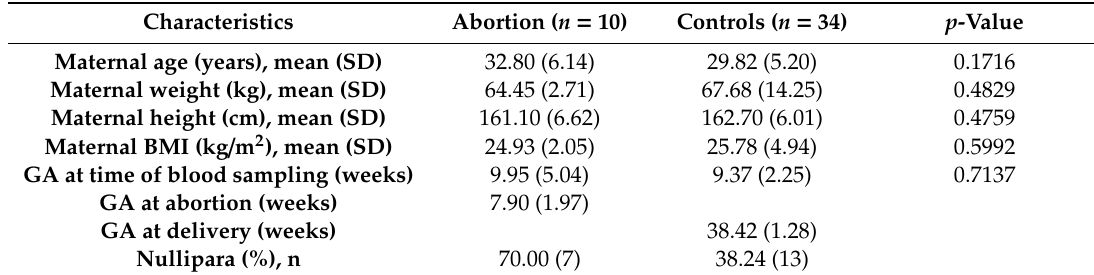
Table 1. Clinical characteristics of controls and spontaneous abortion patients.